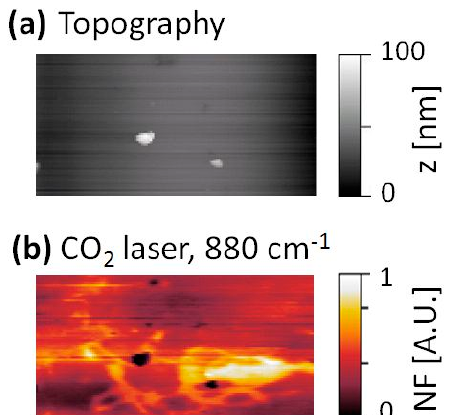
Figure 5. Investigations of KBX reaction products distribution on a 10 − 4 M KBX-treated sample, CCCPX-4b. ( a ) The topography of a 10 μ m × 20 μ m area is depicted. ( b ) Near-field response of the same area at 880 cm − 1 probed with the CO 2 laser, revealing an enhanced signal in a web-like structure.